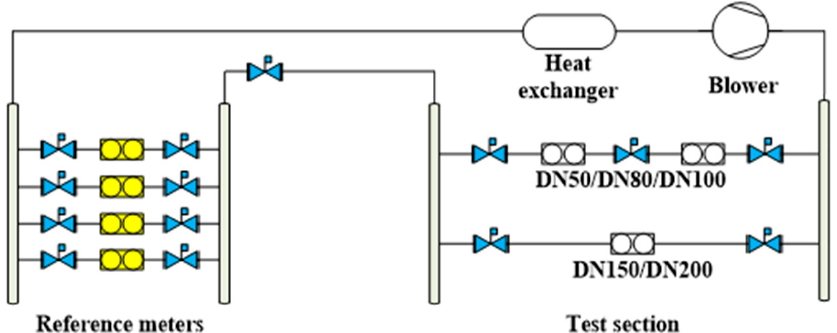
Figure 4. Schematic diagram of the close loop working standard device.